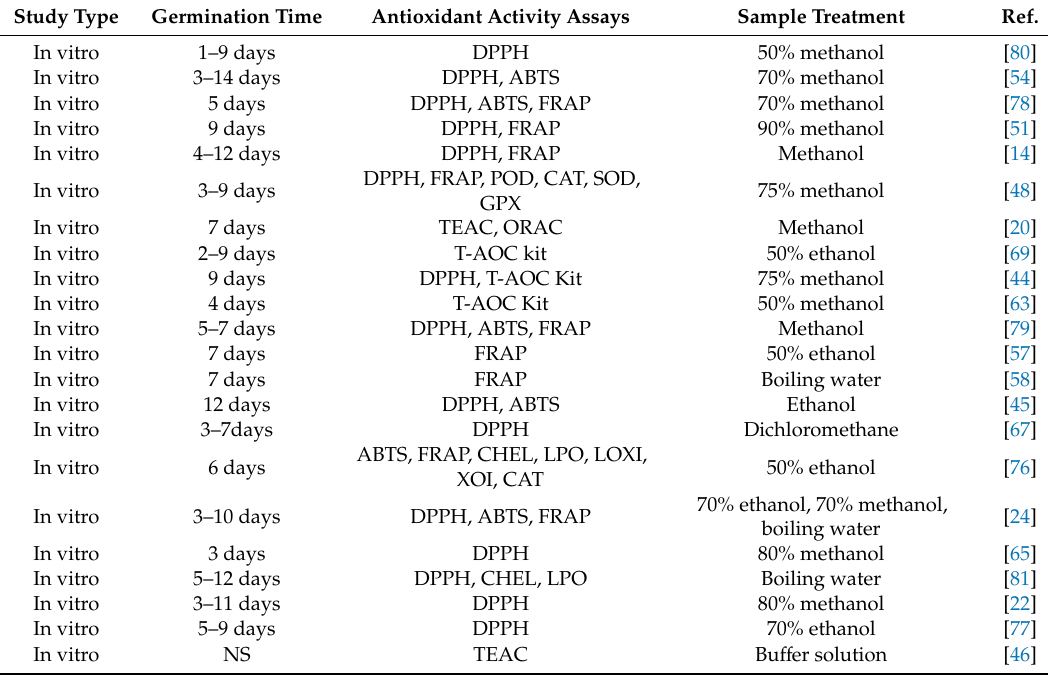
Table 4. Antioxidant activity of broccoli sprouts and